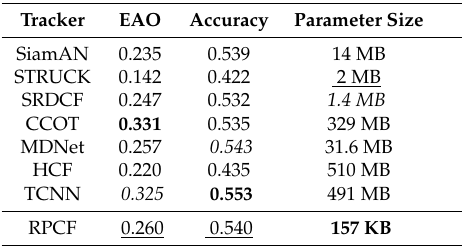
Table 2. Summary of state-of-the-art trackers’ performance on VOT2016. Boldface , italics and underline represent 1st, 2nd and 3rd